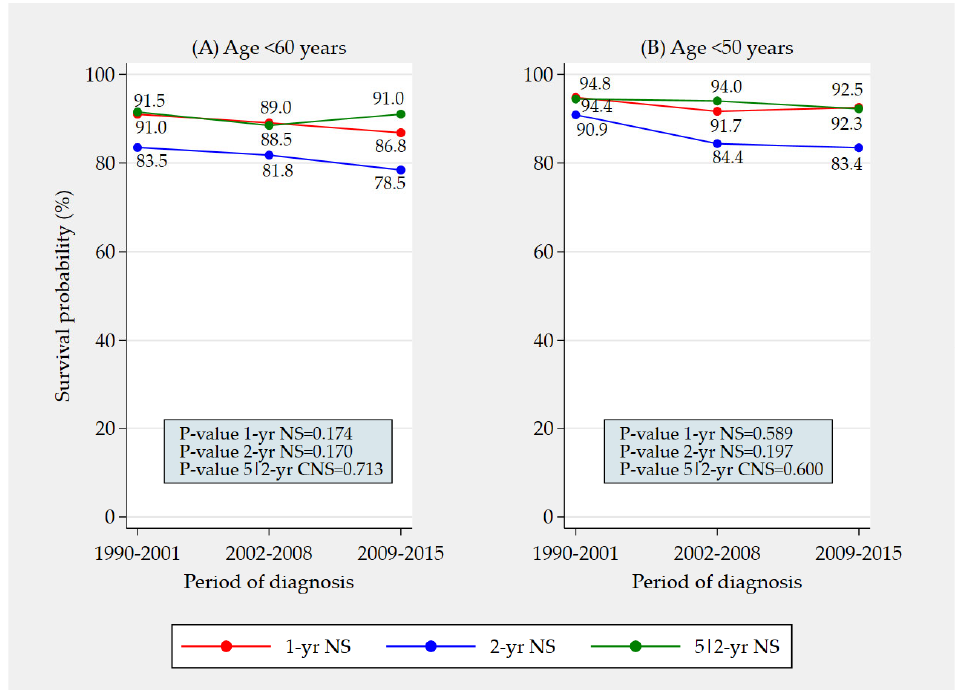
Figure 3. Trends in total 1 ‐ and 2 ‐ year net survival and in 5|2 ‐ year conditional net survival from vulvar squamous cell carcinoma in Italy between 1990 and 2015 among patients aged <60 (i.e., 15–